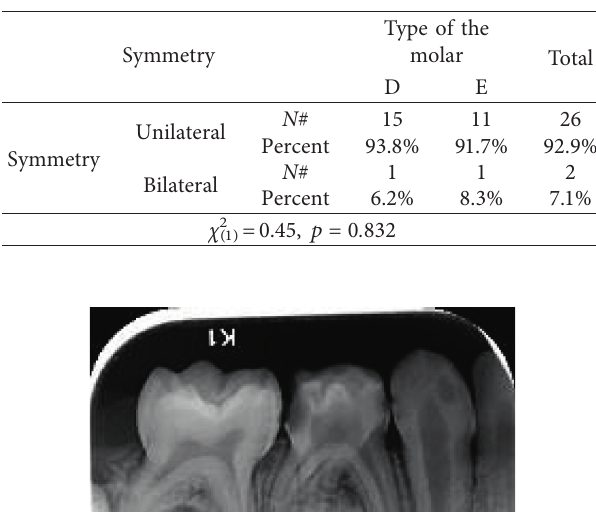
Table 3: Comparison of the frequency distribution of the three- rooted deciduous teeth in terms of symmetry.